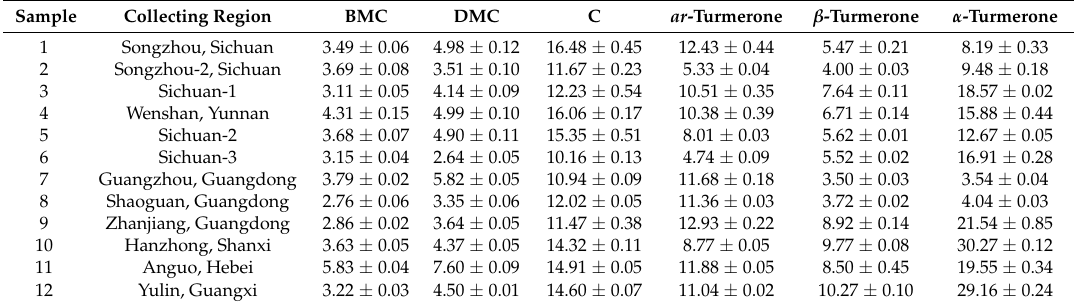
Table 4. Contents of three curcuminoids and three volatile compounds in commercial samples (mg/g). Sample Collecting Region BMC DMC C ar -Turmerone β